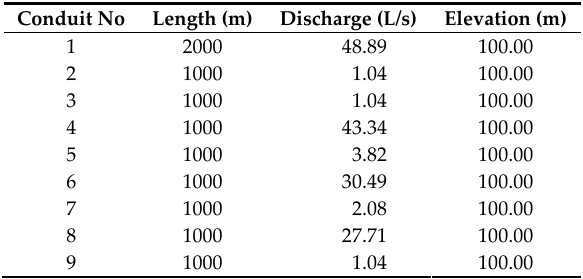
Table 1. Discharges carried by the